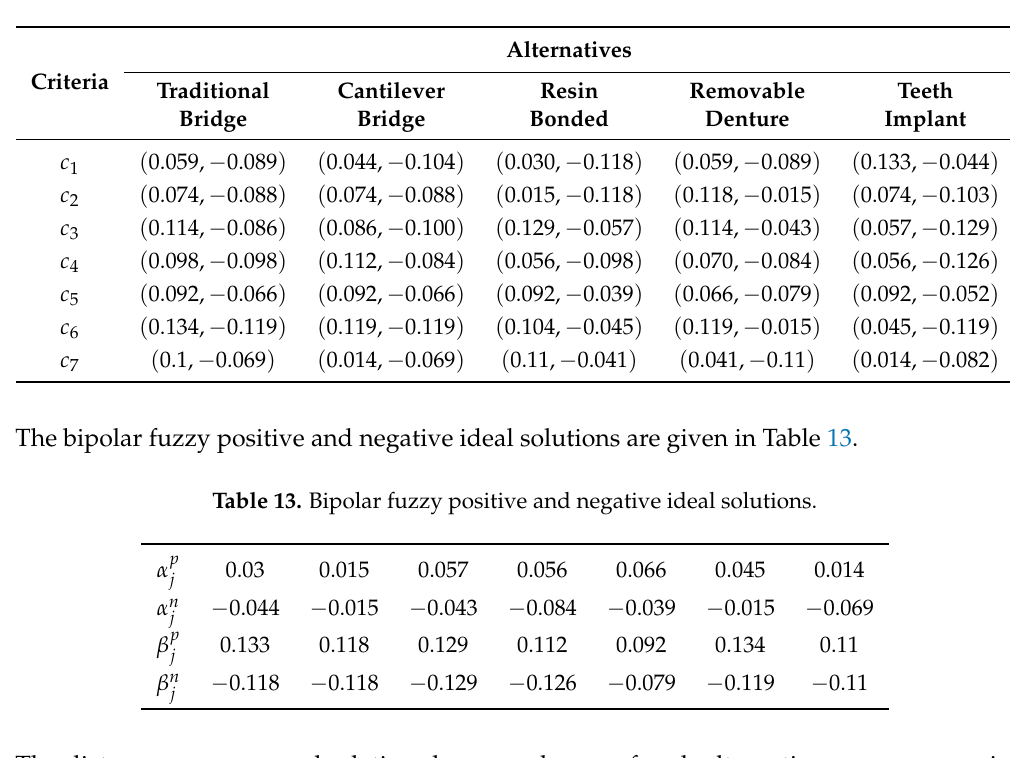
Table 12. Weighted bipolar fuzzy decision matrix.